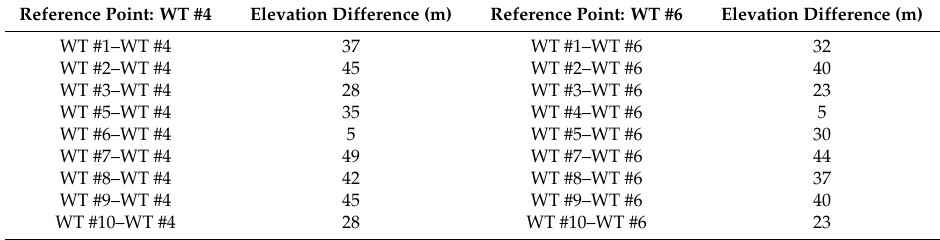
Table 5. Elevation difference between the hub-height of a given WT (a prediction point) and the reference